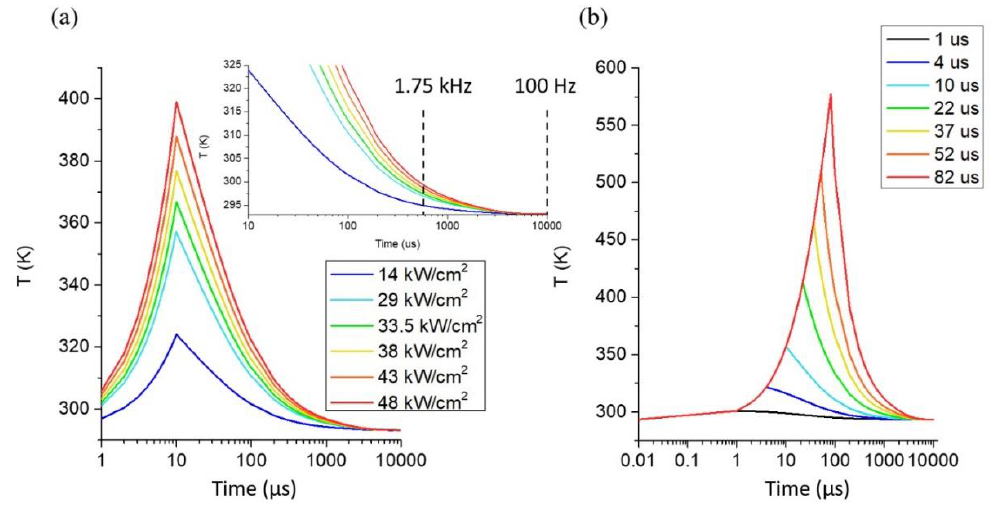
Figure 3. FEM simulation results for laser power ( a ) and pulse width ( b ) tests. The laser power profile shown in ( a ) is based on 10 µ s pulse width and the pulse width profile shown in ( b ) is based on 29 kW / cm 2 laser power density. The laser power is calculated by 90% irradiance over a laser spot area with a diameter of 100 µ m (see the FEM simulation part for details). The mill happens with the power of 33.5 kW / cm 2 and above in ( a ), and with the pulse width of 22 µ s and above in ( b ), corresponding to a threshold peak temperature range of 366 K to approximately 411 K.